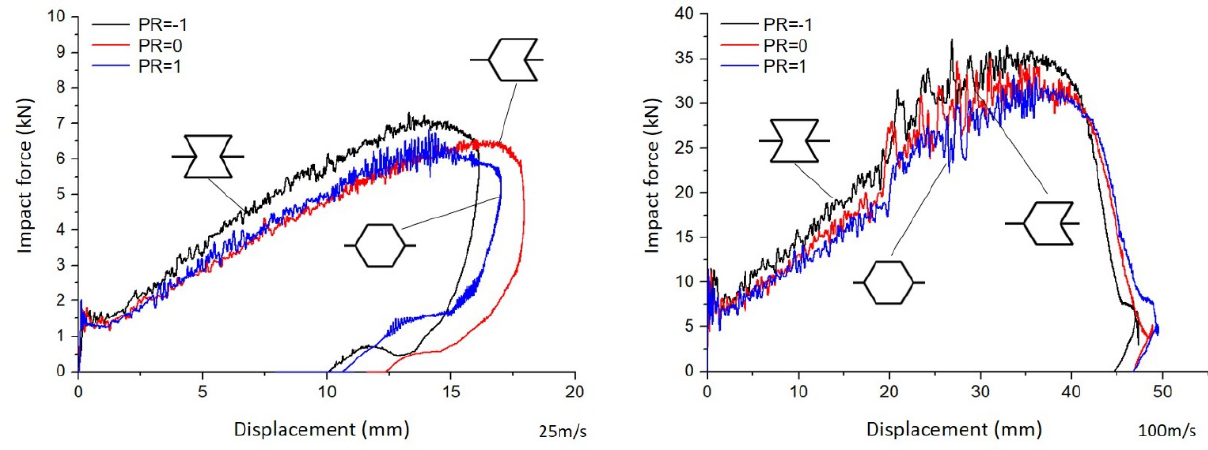
Figure 11: Impact force of sandwich panel with Poisson’s ratio as − 1, 0,